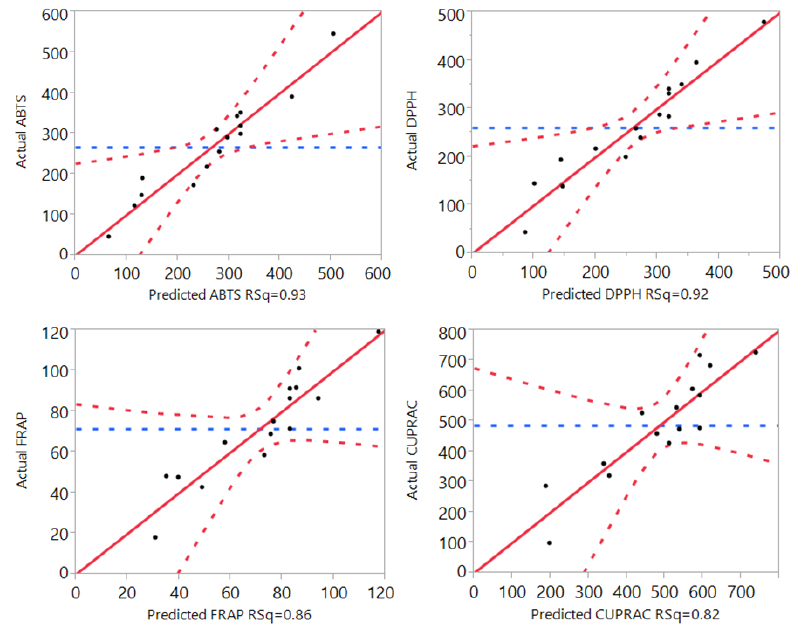
Figure 3. Correlation between the predicted and the actual values for ABTS total antioxidant capacity, DPPH free radical scavenging capacity, cupric reducing antioxidant power (CUPRAC), and ferric reducing antioxidant power (FRAP).